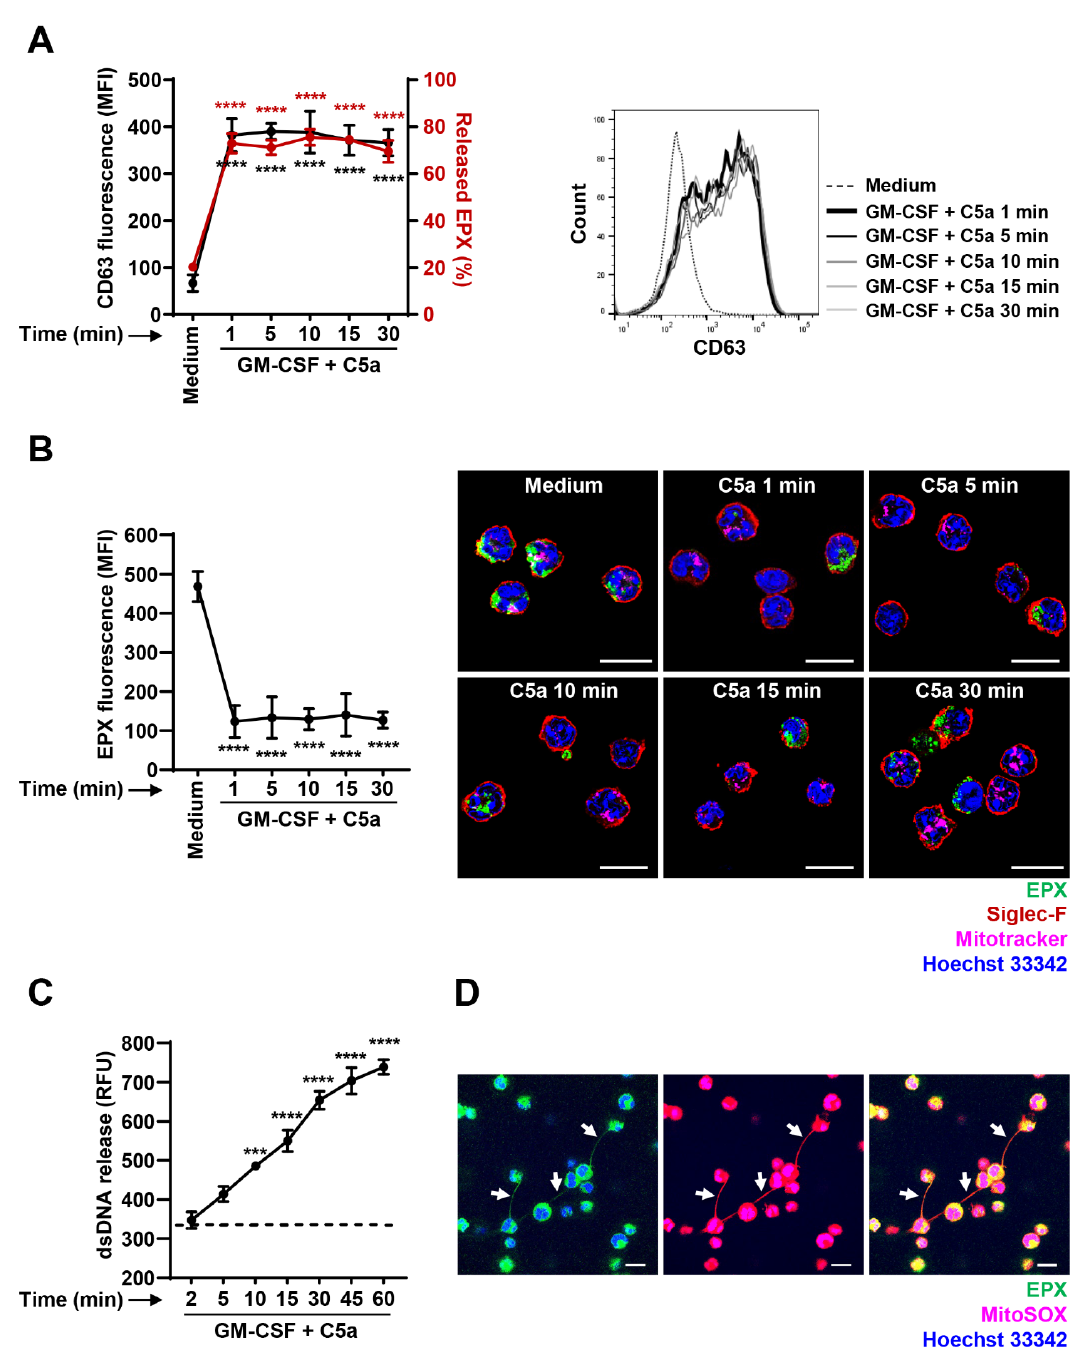
the mean level of spontaneously released dsDNA after 60 min eosinophil culture in the absence of stimulation. ( D ) Confocal microscopy. Human eosinophils were primed with IL-5 and activated with C5a for 15 min. A representative image of EET formation, indicated by white arrows, is shown. Mitochondria, EPX and nuclei were stained with MitoSOX Red, monoclonal mouse anti-EPX antibody and Hoechst 33342, respectively. For better visualization of EETs, the gamma correction function together with min/max thresholds of Imaris software was used to optimize the image display by intensifying the grey value of red (mtDNA) and green (EPX) channels. Bars, 10 µ m. Values are means ± SEM. ** p < 0.01; *** p < 0.001; **** p < 0.0001.